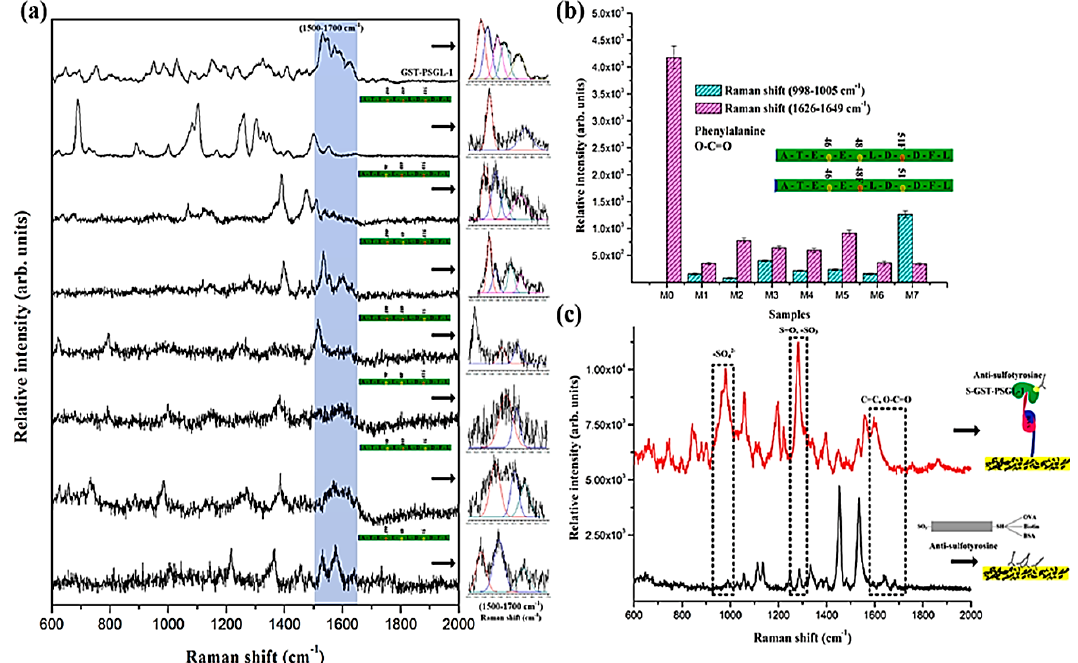
Figure 6. The SERS spectra of the GST-PSGL-1 mutants on the SAM-modified Au nanoporous substrate were examined at a Raman laser wavelength of 633 nm. ( a ) Marked SERS bands at 1500–1700 cm − 1 are highlighted. ( b ) The relationships of relative SERS intensities for the various protein mutants on the Au nanoporous substrate were determined using I SERS peak regions at 998–1005 and 1626–1649 cm − 1 . ( c ) The SERS spectra of S-GST-PSGL-1 and antibody-sulfotyrosine interaction on the Au nanoporous substrate were examined at a Raman laser wavelength of 633